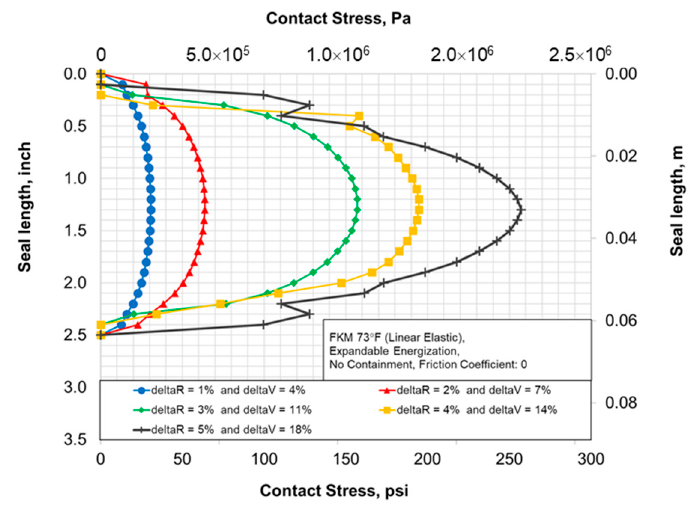
Figure 8. Contact stress profiles generate in expandable seal assembly at different volumetric compression.